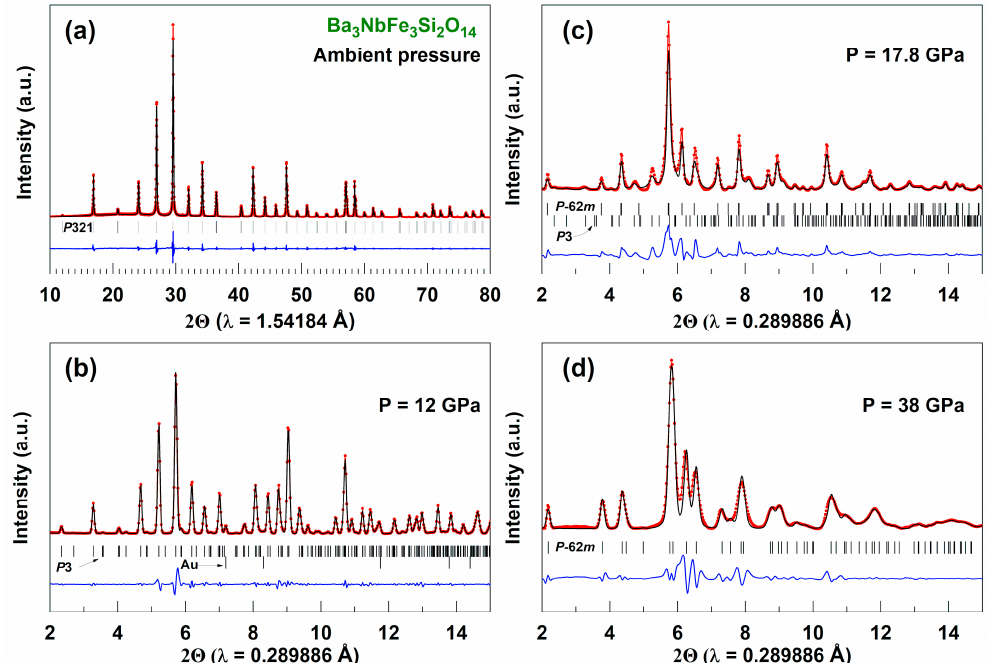
Figure 2. (Colour on-line) Representative powder XRD patterns of Ba 3 NbFe 3 Si 2 O 14 showing the evolution of the crystal structure under applied pressure up to 58 Gpa: ( a ) Ambient pressure; ( b ) 12 GPa; ( c ) 17.8 GPa and ( d ) 38 GPa. Full-profile refinements of the structural modifications of BNFS are shown at selective pressures before and after phase transitions.